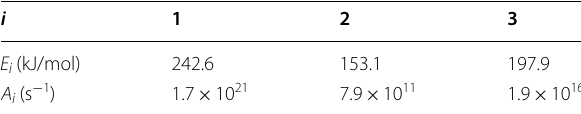
Table 1 Reference values of kinetic parameters E i and A